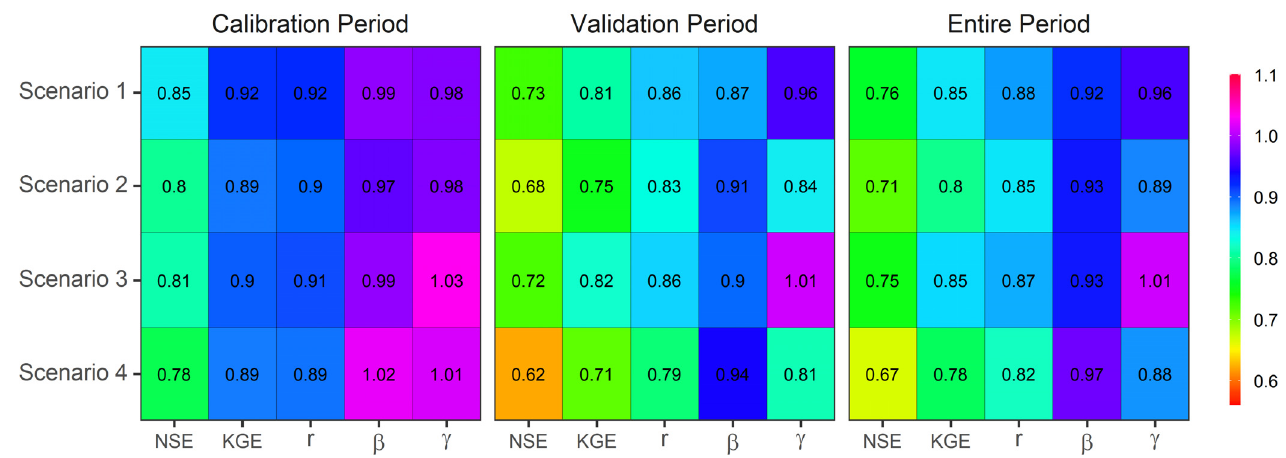
Figure 7. Scatter plot of simulated versus observed streamflow for four scenarios considering the entire period (2015–2019). The color ramp in each scatter plot shows the presence and magnitude of bias between simulated and observed streamflow.